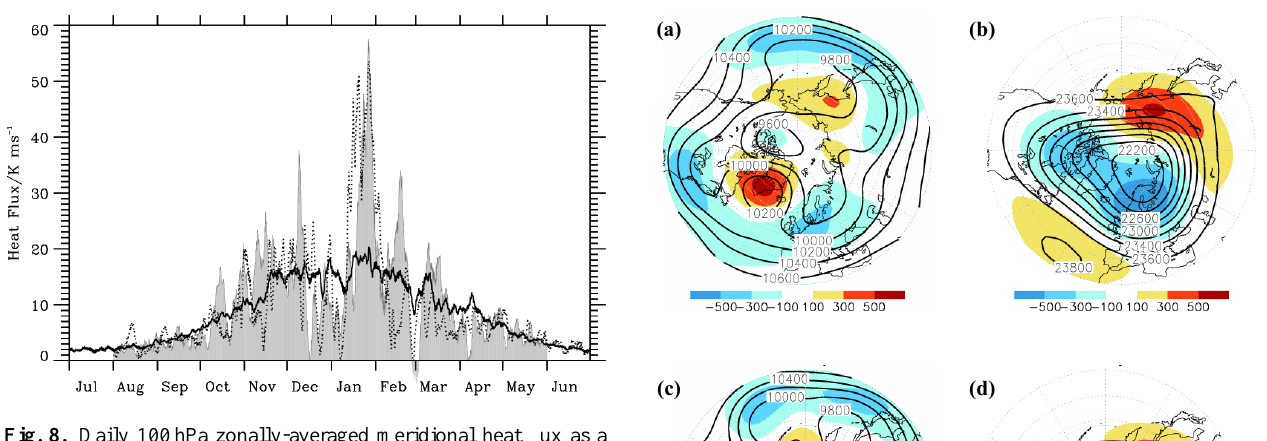
Fig. 8. Daily 100hPa zonally-averaged meridional heat flux as a Figure 8: Daily 100 hPa zonally-averaged meridional heat flux as a function of time for the 2 function of time for the climatology (black line) and 2008/2009 (dotted line), and 2009–2010 (gray shading); compare to Fig. 5 in climatology (black line) and 2008/2009 (dotted line), and 2009/2010 (gray shading); compare 3 Hinssen and Ambaum (2010). to Fig. 5 in Hinssen and Ambaum (2010). 4